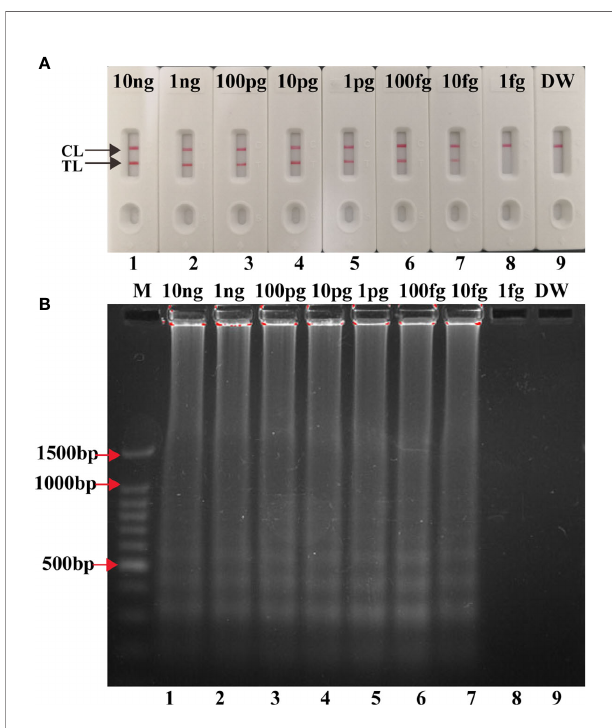
FIGURE 5 | Analytical Sensitivity of multiplex LAMP-LFB assay. Two sets of primers targeting IS 6110 and IS 1081 were simultaneously added to one reaction tube to evaluate the sensitivity of LAMP assay. Two methods were used for ampli fi cation products analysis (A) LFB, (B) 1.5% agarose